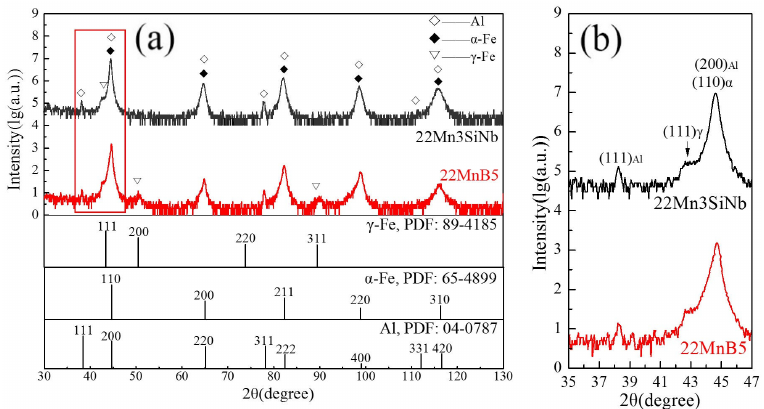
Figure 13. XRD patterns of two investigated steels. ( a ) 30 ≤ 2 θ ≤ 130, ( b ) 35 ≤ 2 θ ≤ 47.